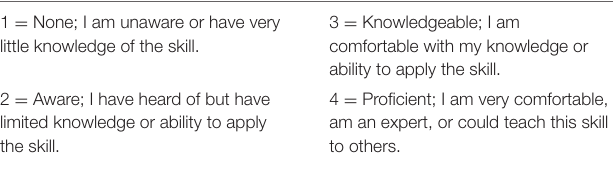
TABLE 2 | Likert scale for baseline and endpoint competency assessment, created by the Council of Linkages